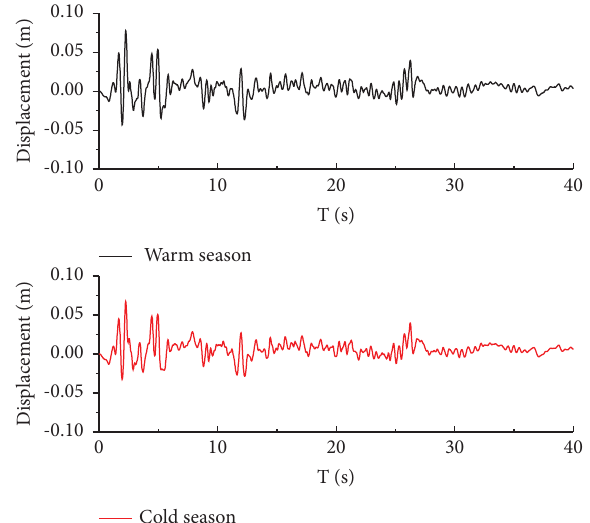
Figure 10: Te displacement time history on the embankment’s shoulder.